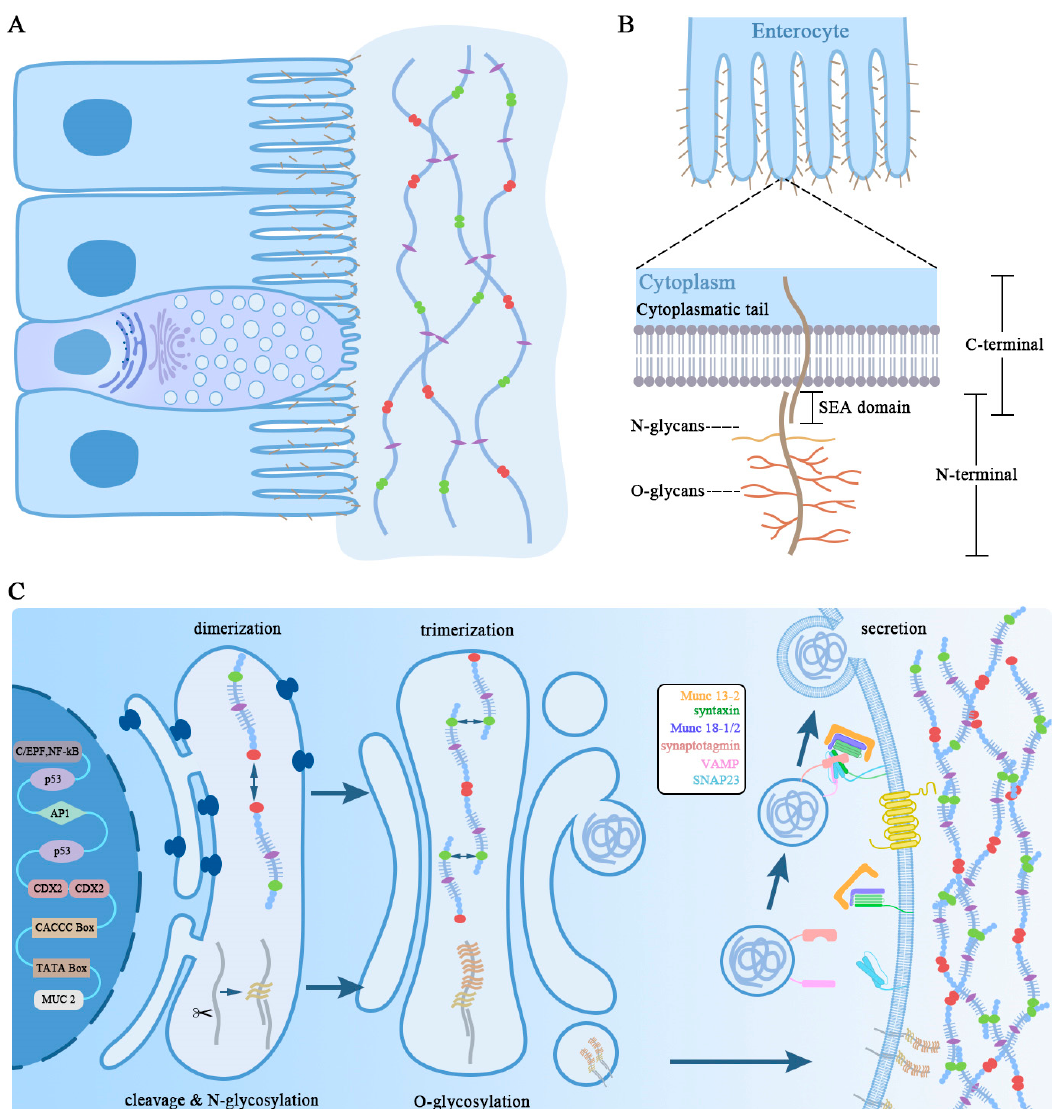
Figure 2. Schematic diagram of MUC2 synthesis, assembly, glycosylation, and process. ( A ) Patterns of distribution and structure of gel-forming secreted from GCs. ( B ) The basic skeleton of membrane- associated mucins shown in the mucin polypeptide chain is N-glycosylated and forms disulfifide- bonded dimers through its C-terminal Cys-rich domains. ( C ) Schematic representation of the dimers transported from ER to the Golgi compartments for the assembling process via a variety of intricate and ongoing processes. The large polymers are deposited in mucin granules in goblet cells and secreted by endocytosis.